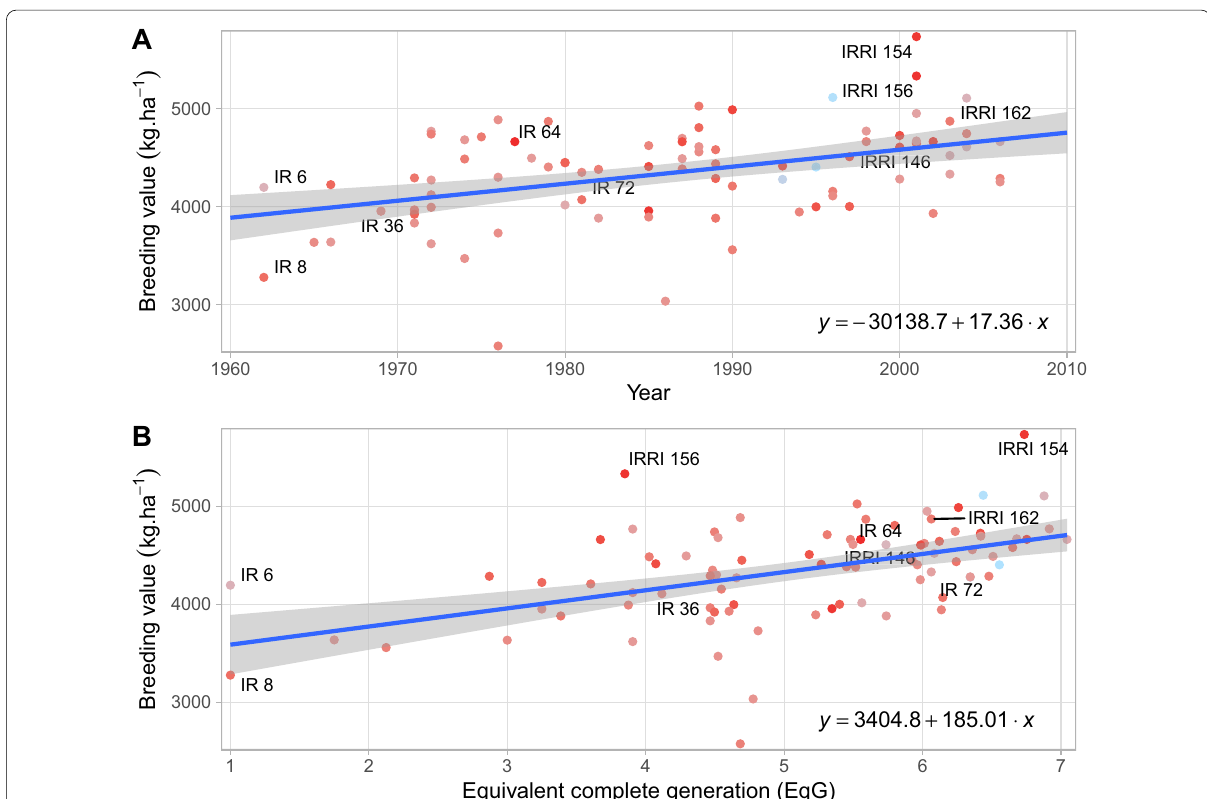
Fig. 3 Trend in breeding values for grain yield on 86 IRRI released varieties. A Evolution of breeding value according to the year the cross was initially made. B Evolution of breeding value according to equivalent complete generation (EqG) as the proxy of realised breeding cycles. The color gradient for the dots represent the reliability of the breeding values from low (blue) to high (red). The blue lines represent the linear regression of the breeding value on the year or EqG. The associated equations are also